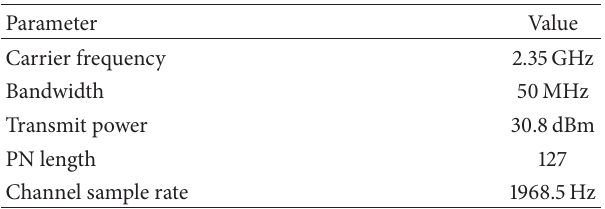
Table 1: Measurement